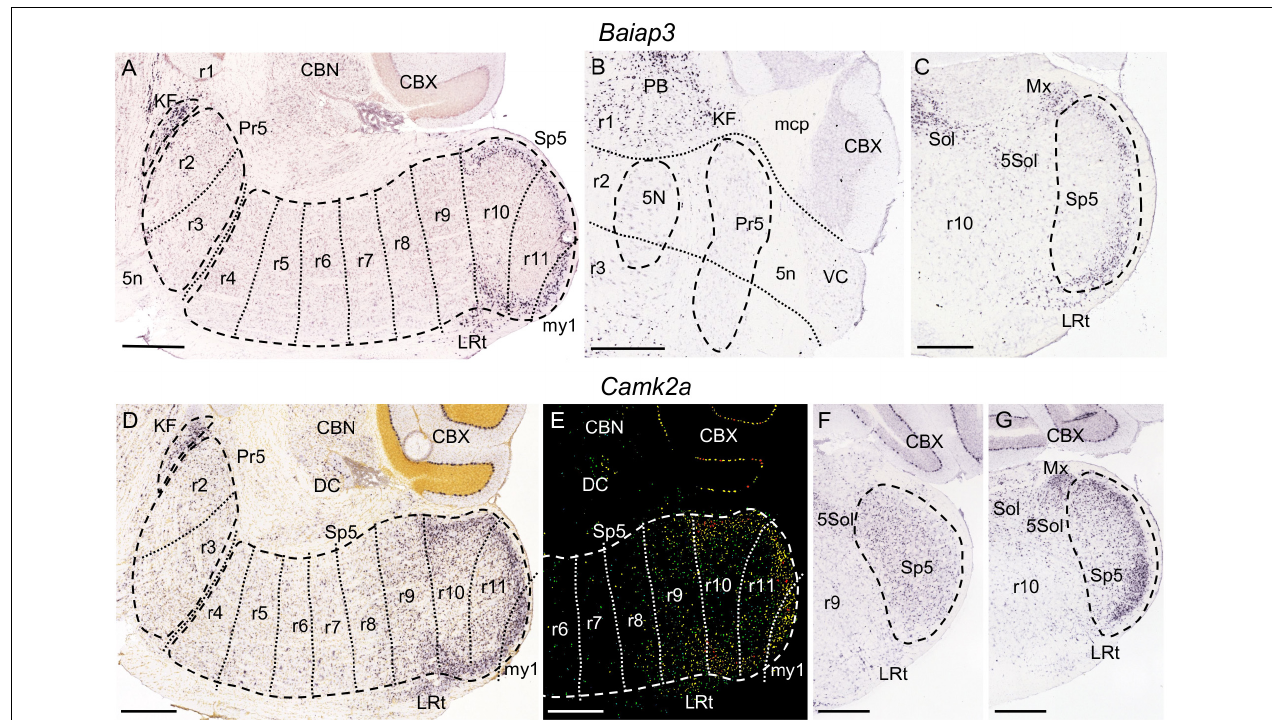
FIGURE 4 | Baiap3 (A–C) and Camk2a (D–G) expression. (A) Parasagittal section from adult brain at a lateral level showing the full extent of the trigeminal column (Pr5 plus Sp5, respectively, encircled by dashed lines). KF is also encircled by dashed lines. In this and following parasagittal sections, each of the proposed interrhombomeric boundaries (dotted lines) is represented only within the trigeminal column regarding the objective of this work. There is Baiap3 expression in KF as well as in the r10 and r11 portions of the trigeminal column, concretely in its gelatinous layer. In (A,D,E) these parasagittal planes include only a small and superficial portion of my1, because this segment lies medially as compared to the rhombomeres, accordingly to the small mediolateral diameter of the spinal cord as compared to the hindbrain (see Figure 1B ). (B) Coronal section from adult brain at the level of the trigeminal motor nucleus (5N) crossing through r1, r2 and r3. There is Baiap3 expression in KF and other parabrachial nuclei (PB) within r1, while Pr5 (encircled by dashed lines) remains negative in this section. (C) Coronal section from adult brain at the level of r10, showing Baiap3 expression in the gelatinous layer of Sp5 (encircled by dashed lines) as well as in the lateral reticular nucleus (LRt), the solitary nucleus (Sol), the trigeminal-solitary transition zone (5Sol) and the matrix region of the medulla (Mx). (D,E) Respective brightfield and color-coded images of a parasagittal section from a P28 brain processed for detection of Camk2a expression. Besides KF and LRt, there is expression in the r10 and r11 portions of Sp5, with a laminar pattern showing higher intensity in its gelatinous layer. The r9 portion of Sp5 express this gene homogeneously, with a gradient expression extending into r8. In the rest of rhombomeres, from r2 to r7, there is expression in some scattered cells. (F,G) Respective coronal sections from adult brain at r9 and r10 levels of an adult brain, displaying their aforementioned expression pattern in the respective portions of Sp5. Positive zones for Camk2a expression close to Sp5 include Sol, Sol5, Mx and LRt. Scale bars = 500 µ m.